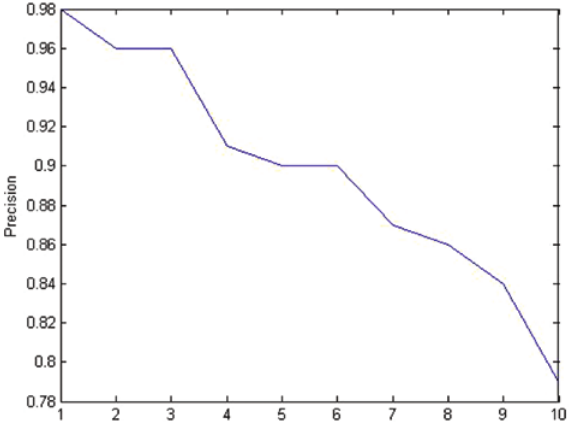
Figure 8: Evaluation of